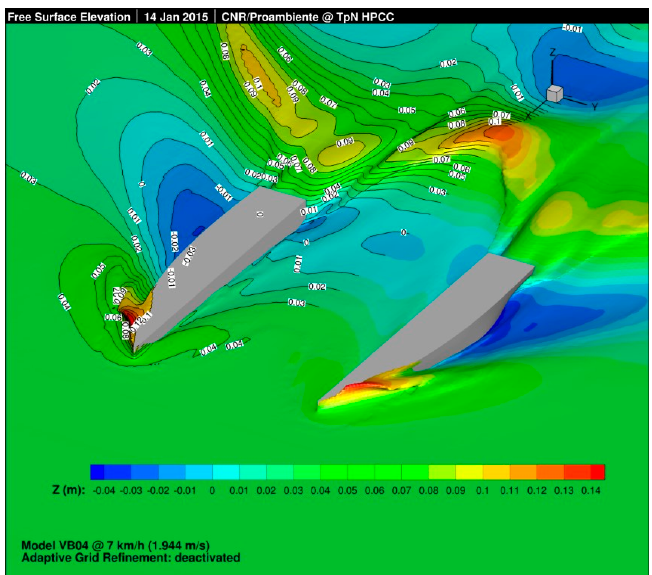
Figure 2. CFD simulation of the hulls behavior during the design phase of the vehicle at 7 km/h of speed. Note minimum turbulence between the two hulls.